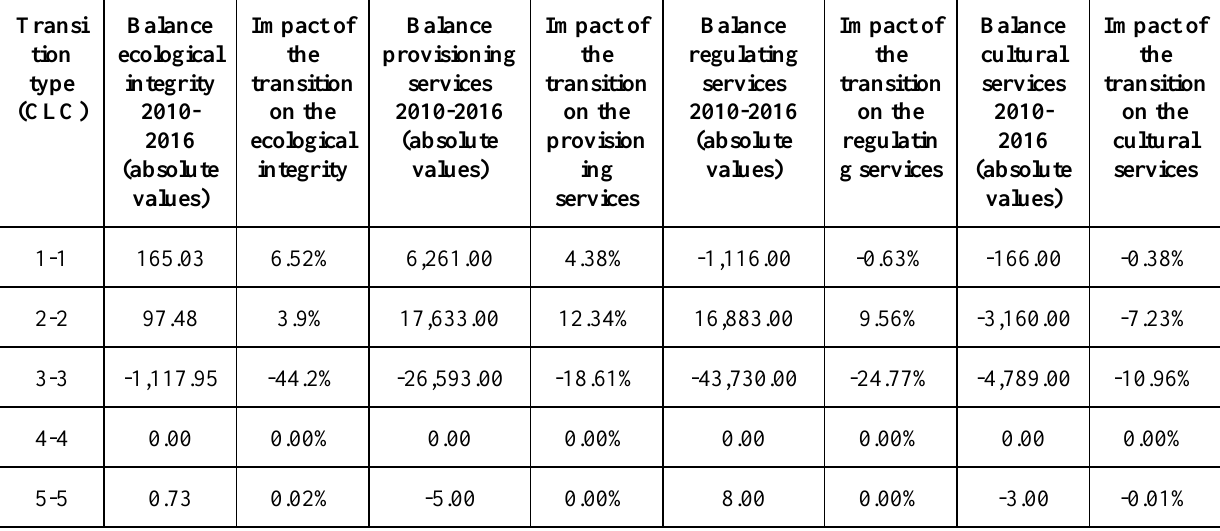
Table 5. Transition 2010-2016 of ecosystem services (support, provisioning, regulating, cultural-recreational): contributions of transitions within the same class classes at the first classification